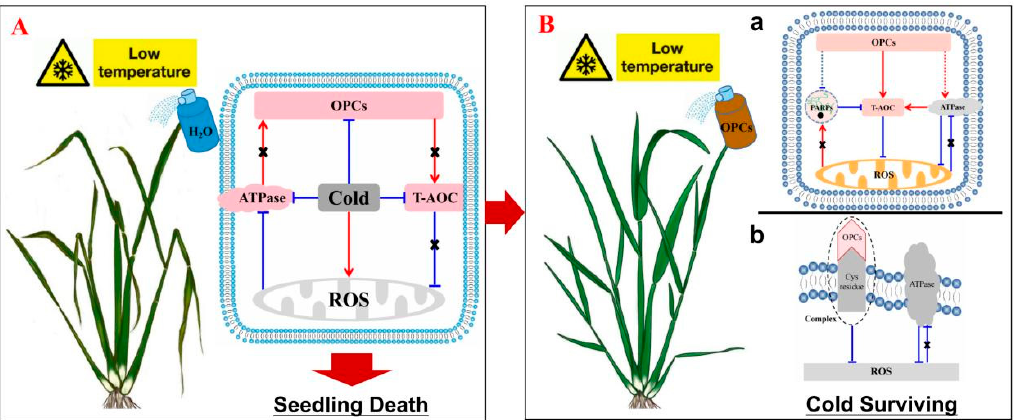
Figure 9. Descriptive model of the function of OPCs in conferring cold tolerance in rice. ( A ), Cold stress significantly inhibits OPC synthesis, impairs T-AOC and ATPase activity, resulting in excess ROS accumulation, leading to seedling death. ( B ) (a), Exogenous OPCs enhance T-AOC and reduce the excess ROS caused by cold stress. This alleviates the activation of PARP, inhibition on ATPase activity of rice under cold stress, and thus provides sufficient available energy for the formation of antioxidants. ( B ) (b), OPCs combine with Cys residues to form a complex at the plasma membrane to scavenge intracellular ROS to stabilize ATPase activity under cold stress [92]. Taken together, OPCs could improve energy status to enhance cold tolerance in rice plants. OPCs, oligomeric proanthocyanidins; PARP, poly (ADP-ribose) polymerase; T-AOC, total antioxidant capacity; ROS, reactive oxygen species; Cys residue, cysteine residue.